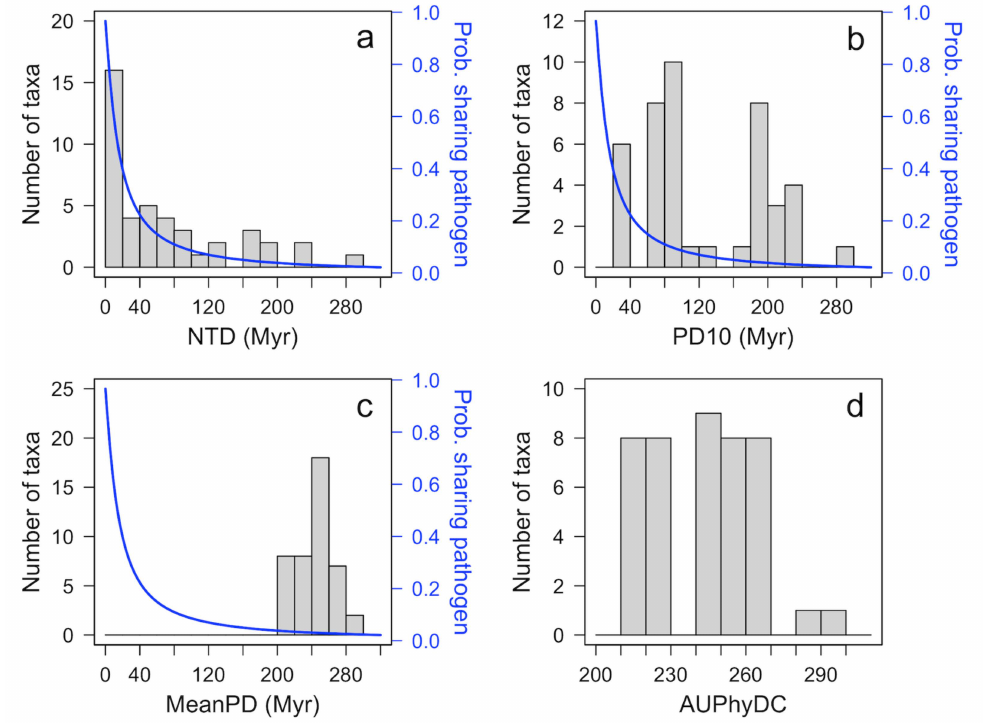
Figure 4. Distributions of four one-to-many metrics of phylogenetic distance. ( a ) Phylogenetic distance to the most closely related taxon (NTD); ( b ) the 10 th quantile distance from the focal species to the remaining taxa (PD10); ( c ) mean phylogenetic distance from each focal taxon to the remaining taxa (meanPD); ( d ) area under the phylogenetic distance curve (AUPhyDC) for each focal taxon, as de- scribed in Figure 5. Metrics were calculated for each of the 43 angiosperm focal taxa shown in Figure 1. For all metrics, phylogenetic distance from a taxon to itself is excluded. The blue curve indicates the empirically measured phylogenetic signal of two plant species sharing a fungal pathogen, where logit (probability of sharing) = 3.35861 − 2.857656 × log 10 (1 + phylogenetic distance in Myr)